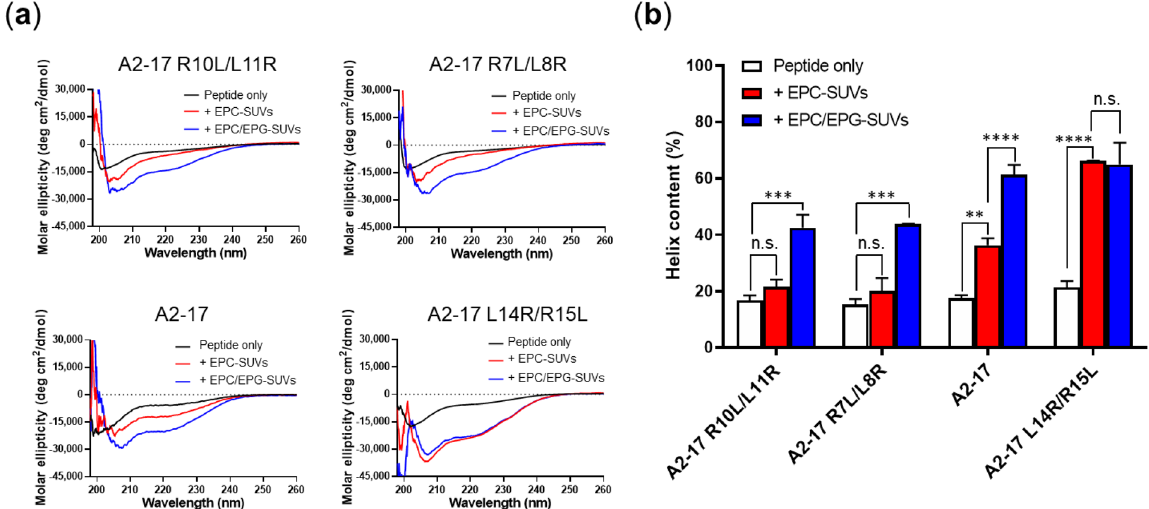
Figure 2. ( a ) Far-UV CD spectra of A2-17 structural isomers in the absence (Peptide only) or presence of lipid vesicles (+ EPC-SUVs or + EPC/EPG-SUVs; lipid/peptide molar ratio = ~ 61) in 10 mM Tris buffer (150 mM NaCl, pH 7.4). Weight amounts of peptides that were determined by the BCA method may have slightly different peptide content, giving the variation in CD signal (black curve). ( b ) α-Helix contents of peptides in the absence (Peptide only) or presence of lipid vesicles (+ EPC-SUVs or + EPC/EPG-SUVs). Data for A2-17 are from our previous study 11 . ** p < 0.01; *** p < 0.001; **** p < 0.0001; n.s., not